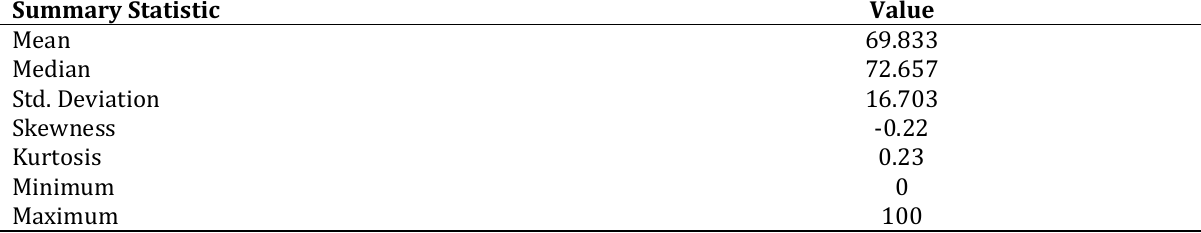
Table 15: Summary statistics of the level of sensitivity for fuzzy